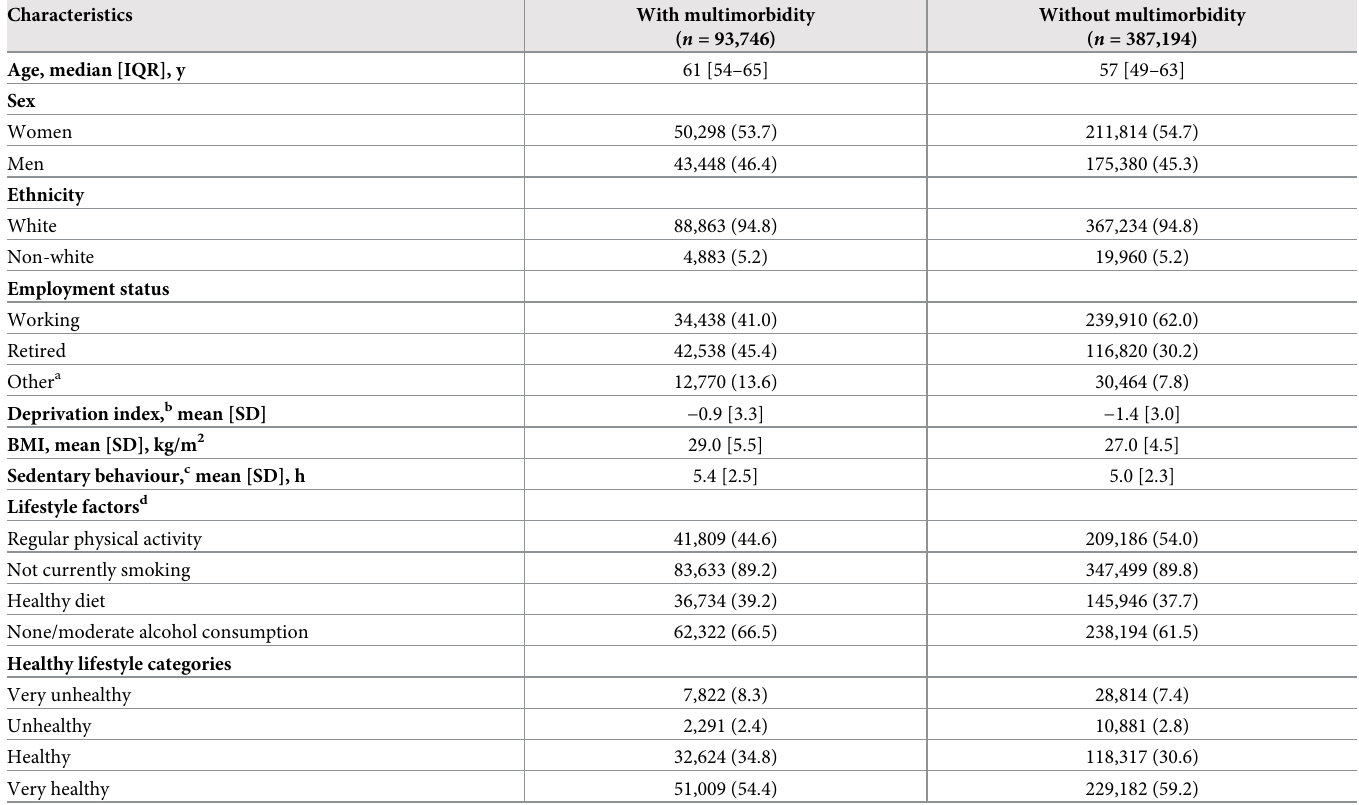
Table 1. Baseline characteristics of participants by multimorbidity